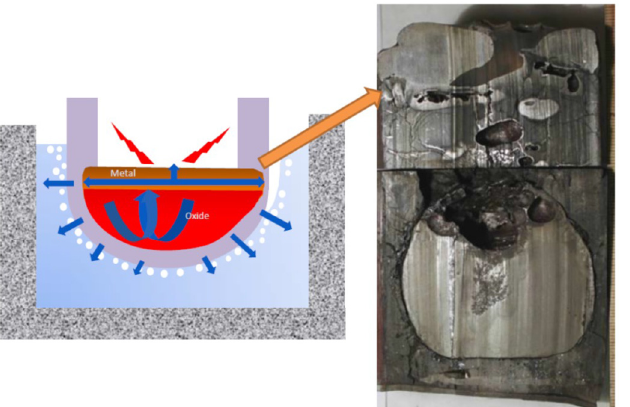
Fig. 4. CORDEB experimental data.